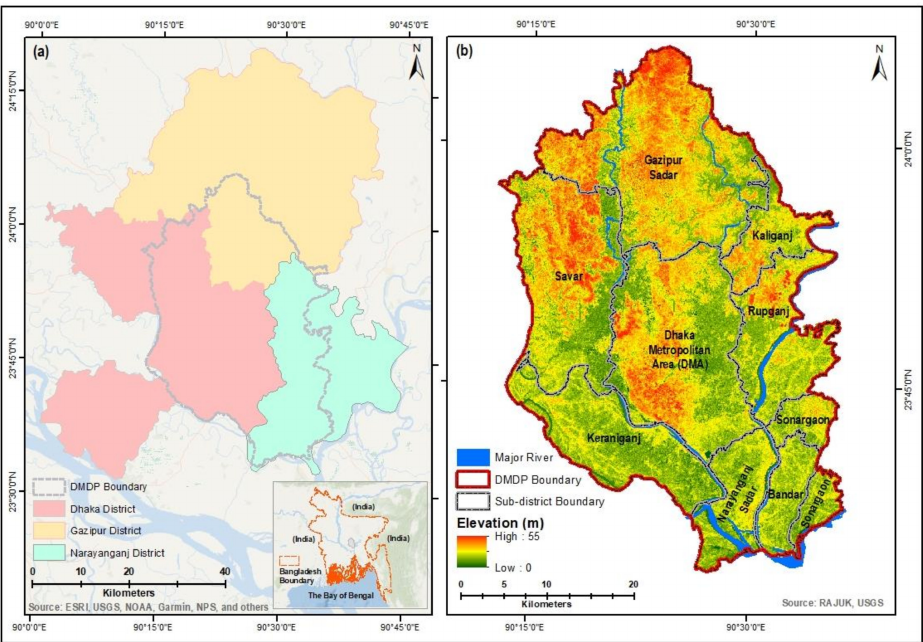
Figure 1. Location of the study area: ( a ) the Dhaka Metropolitan Development Plan (DMDP) area within the national context; ( b ) the Dhaka Metropolitan Development Plan (DMDP) area and its corresponding sub-districts’